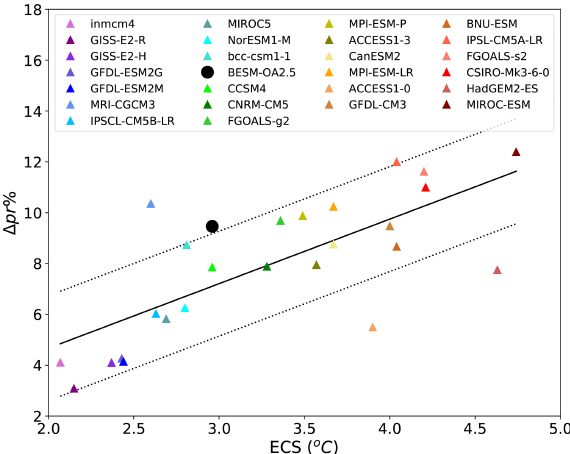
Figure 10. Scatter plot of the ECS and (cid:49) Pr (%) values for all of the ensemble models. The solid black line shows the linear fit be- tween the ECS and the perceptual precipitation change. As in Fig. 2, the models are sorted according their ECS value. The dashed lines represent the error limits considering the residual standard